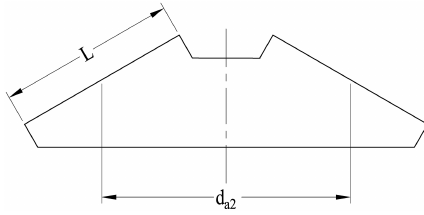
Figure 5. Rotary surface of the driven line